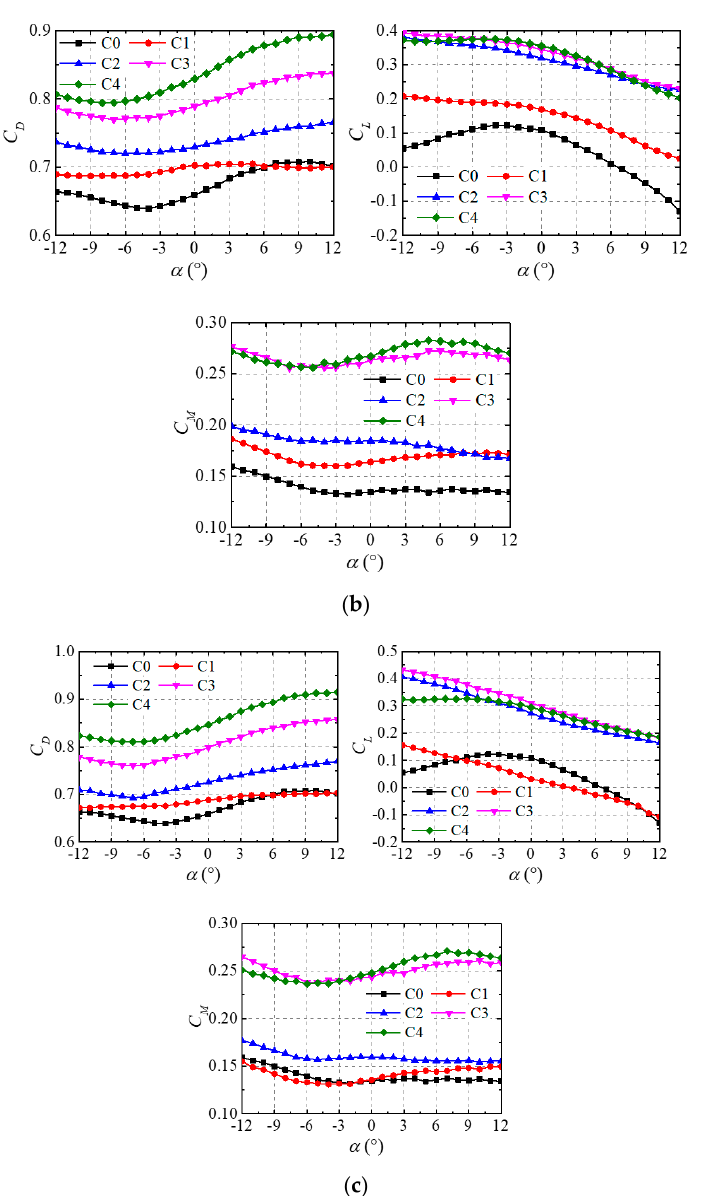
Figure 25. Aerodynamic force coefficients of section with various ice classes ( U = 15.5 m/s): ( a ) pipeline with crescent-shaped ice, ( b ) pipeline with D-shaped ice, ( c ) pipeline with sector-shaped ice. Aerodynamic force coe ffi cients of section with various ice types for C4 ice class were shown in Figure 26. Ice accretion had a negligible e ff ect on the variation of the aerodynamic force coe ffi cients ◦ ◦ with α . C L of the ice-free model gradually increased with increasing α in the range of α = − 12 to − 2 ◦ ◦ and then gradually decreased with increasing α in the range of α = − 2 to 12 . C L for the pipeline with ◦ ◦ D-shaped ice was almost invariant in the range of α = − 12 to − 3 and then gradually decreased with increasing α . The C L values for pipelines with crescent- and sector-shaped ice gradually decreased with increasing α . The C L and C M values for the pipeline with D-shaped ice were larger than those with crescent- and sector-shaped ice. In conclusion, the aerodynamic force coe ffi cients of the iced sections were much higher than those of the ice-free one, which may be ascribed to the large windward area and the asymmetry of the ice-accreted